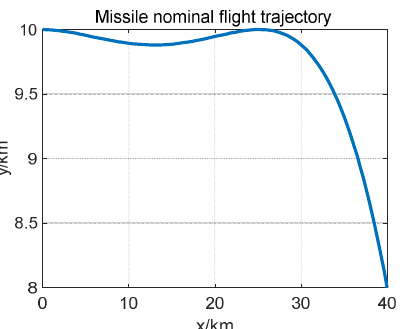
Figure 1. Optimal trajectory in the two-dimensional plane.